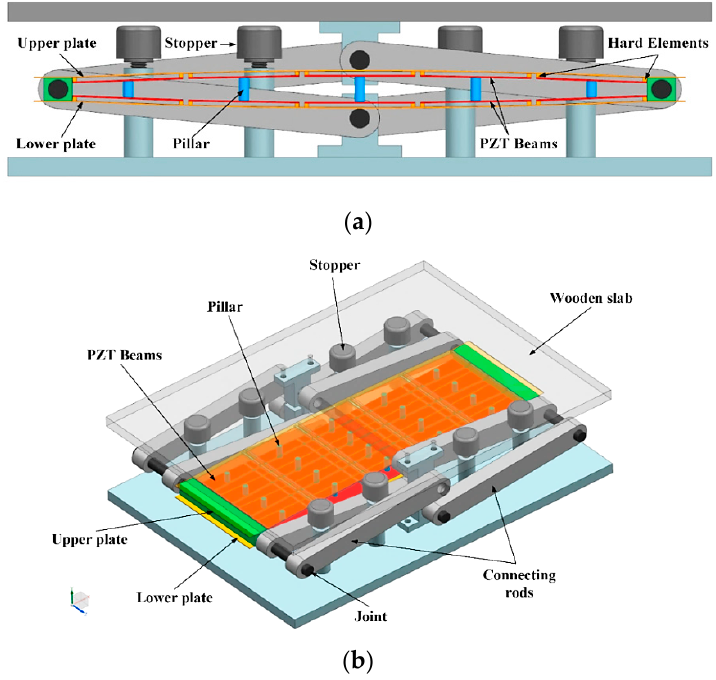
Figure 16. Schematic of the “squeezing structure”: front view ( a ) and three-dimensional rendering ( b )